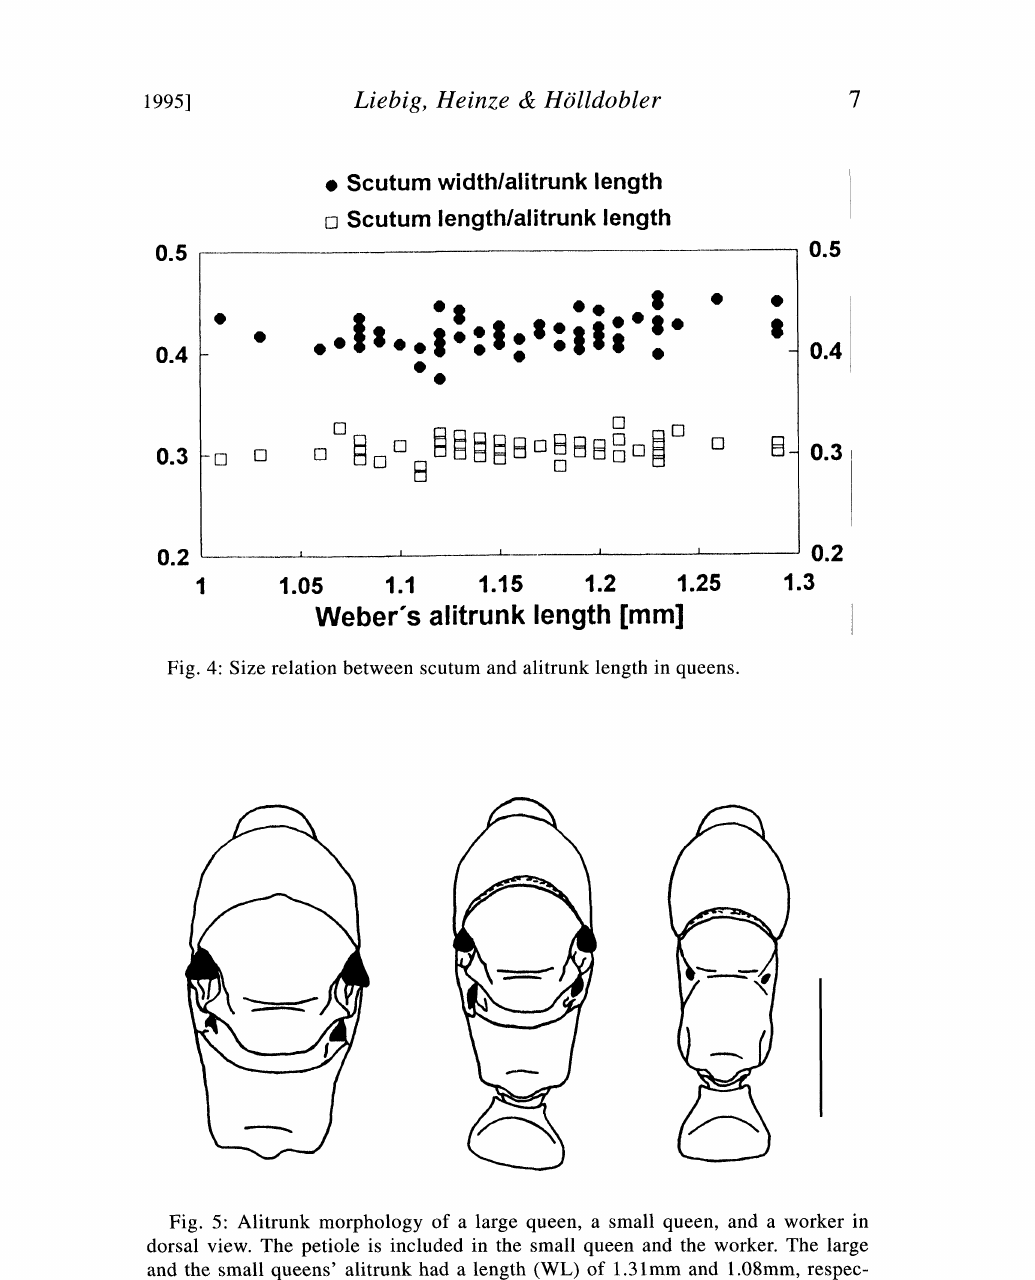
Fig. 5: Alitrunk morphology of a large queen, a small queen, and a worker in dorsal view. The petiole is included in the small queen and the worker. The large and the small queens’ alitrunk had a length (WL) of 1.31mm and 1.08mm, respec- tively. The scale equals 0.5